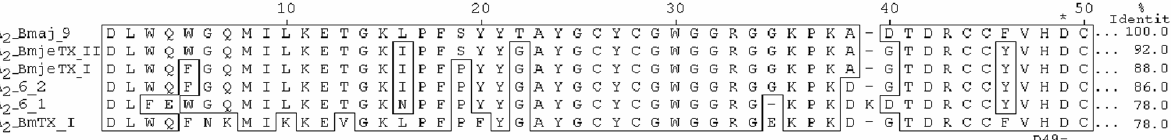
. BmjeTX-I and -II from 2